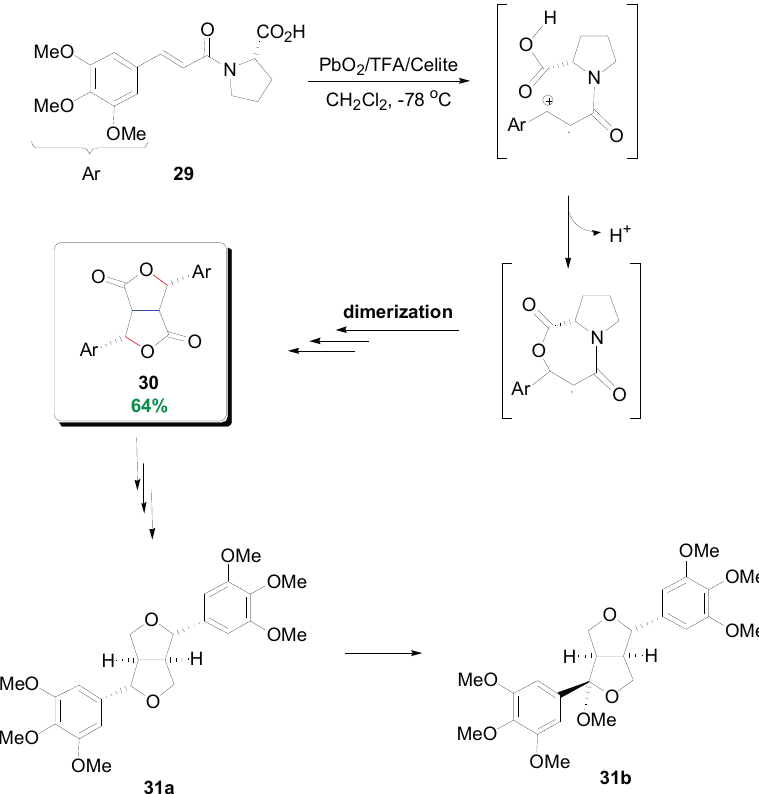
( 29 ) of O -methylsinapic acid with L